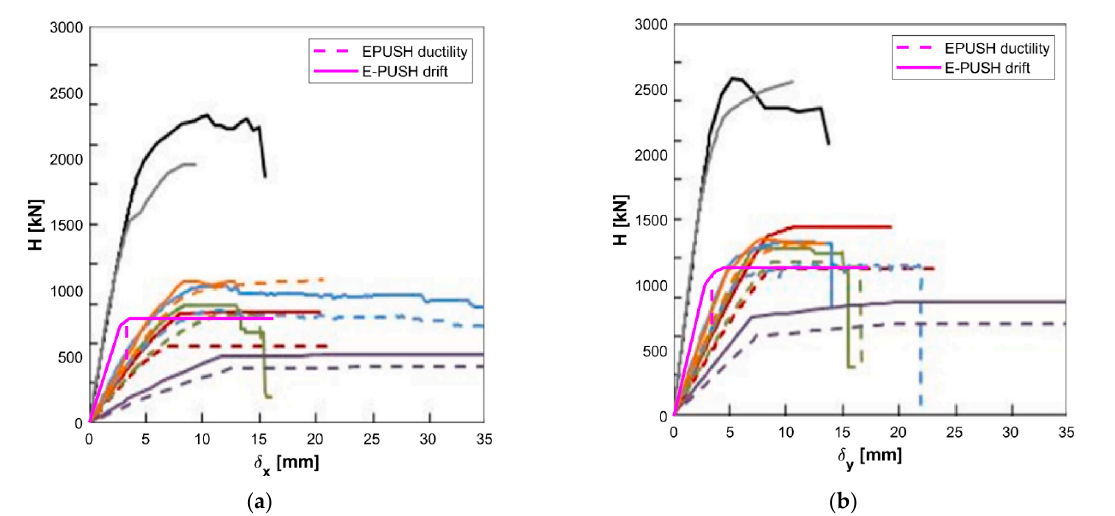
Figure 4. Comparison of capacity curves obtained from the benchmark exercise Case B in [24] and those obtained from the E-PUSH software (in magenta) ( a ), Longitudinal direction X, ( b ) Transversal direction Y. (Longitudinal direction is the shorter dimension in the plan.)